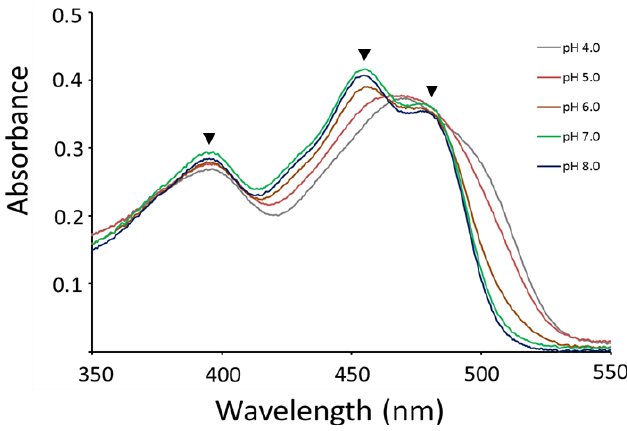
Figure 6. UV – visible absorption spectra of oxidized MMOR-FAD depending on the pH. Optical spectra were measured of purified MMOR-FAD (97 – 343 residues of MMOR from M. sporium 5) at different acidity values. Filled triangles represent flavin absorptions at 396, 456, and 476 nm.